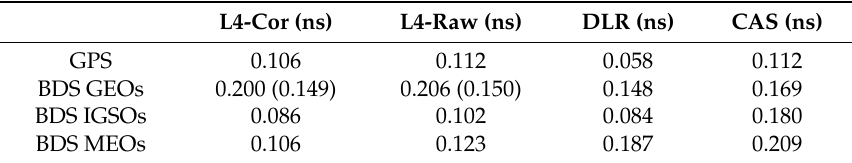
Table 3. Stability statistics of GPS and BDS satellite DCBs from the L4-cor, L4-raw, DLR and CAS solutions. The BDS satellites are categorized as BDS GEOs, BDS IGSOs and BDS MEOs; and their respective stabilities are calculated. The L4-cor and L4-raw BDS GEOs stability values in the brackets represent the results without C02 and C05 Figure 4. Monthly STD values of the GPS and BDS satellite DCBs. The L4-cor, L4-raw, DLR and CAS solutions are given in different colors.